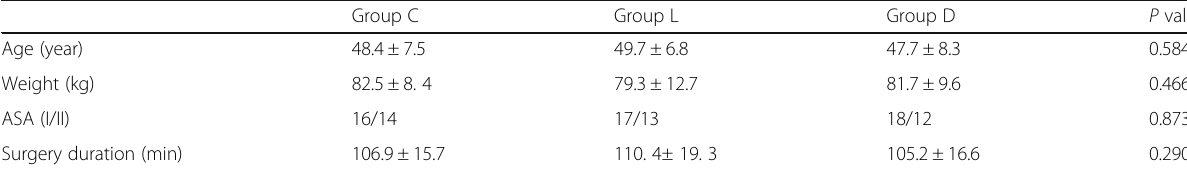
Table 1 Demographic patients ’ characteristics (mean ± SD or ratio)